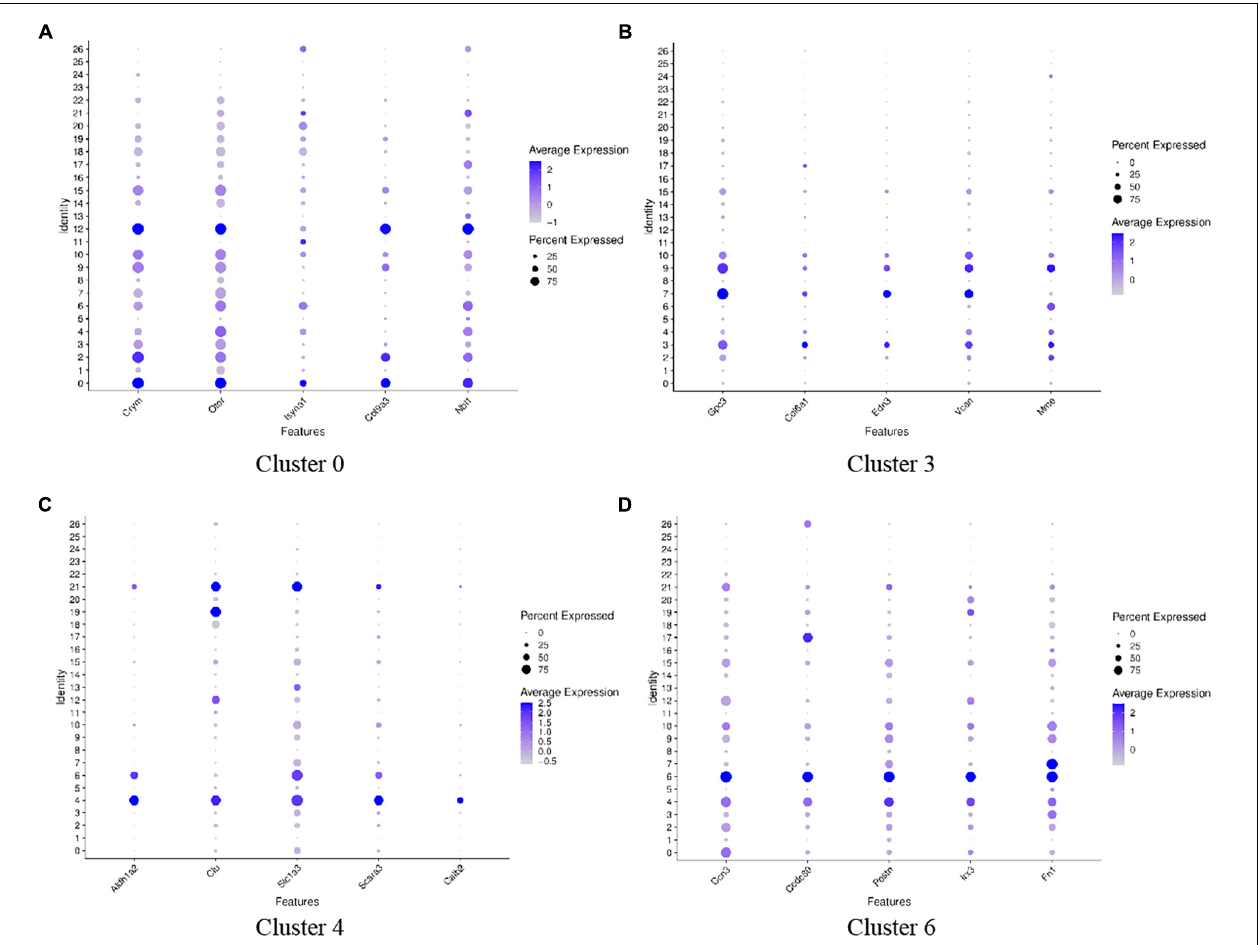
FIGURE 4 | Dot plots representing expression levels of cochlea cells. scRNA-seq was performed on single-cell suspensions pooled from the cochlea duct of SD rats including P1 and P7 stages. All samples were analyzed using Dot plot analysis with the Seurat R package. Expression levels of the top five genes on cluster 0 (A) , cluster 3 (B) , cluster 4 (C) , cluster 6 (D) are shown. Each dot was sized to represent the proportion of cells of each type expressing the marker gene and colored to represent the mean expression of each marker gene across all cells, as shown in the